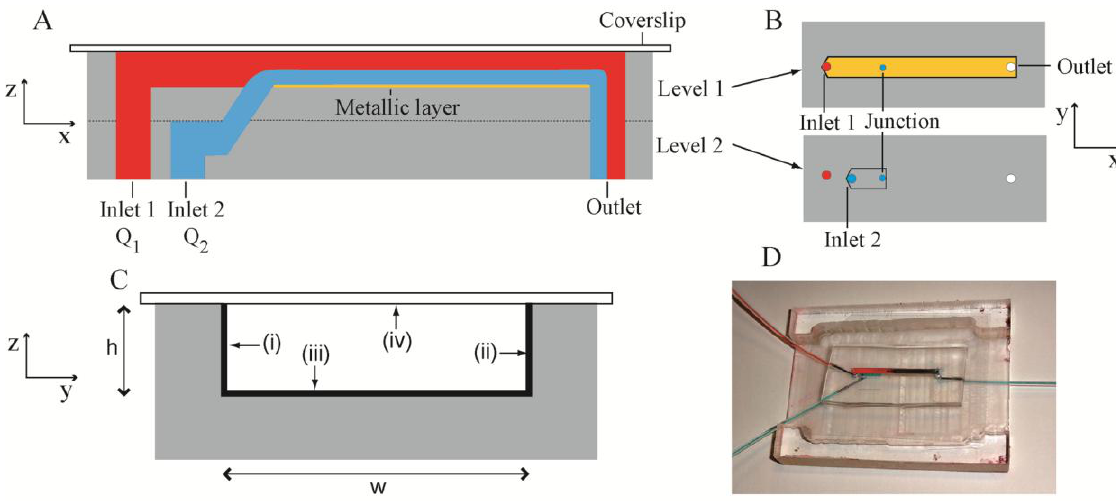
Figure 1. ( A ) Schematic showing the cross-section of a two-level MF bioreactor in the x-z plane. Inlet 1 is used to introduce the sheath flow solution (red) at flow rate Q . Inlet 2 is used 1 to introduce the biofilm precursor flow (blue) at flow rate Q . The red flow confines the blue 2 flow at the bottom of the microchannel. ( B ) Schematic of the two levels in the x-y plane. The junction, the inlets and the outlet are represented by circles. ( C ) Schematic showing the cross-section of the Level 1 channel in the y-z plane. The channel walls consist of PDMS (grey) covered with an opaque metal layer (black) on the side walls (i, ii) and the bottom SERS sensing surface (iii). A glass sealing layer defines the fourth channel surface (iv). The channel dimensions are h = 305 µm and w = 2 mm (not to scale). ( D ) Photograph of an operational MF bioreactor with inlet tubes delivering red and blue coloured solutions to inlets 1 and 2, respectively. The MF bioreactor is oriented with the glass side up for inspection by Raman spectrometer and optical imaging. The holder provides space on the PDMS side of the bioreactor for tubing to be connected to inlets and outlet via metal elbow